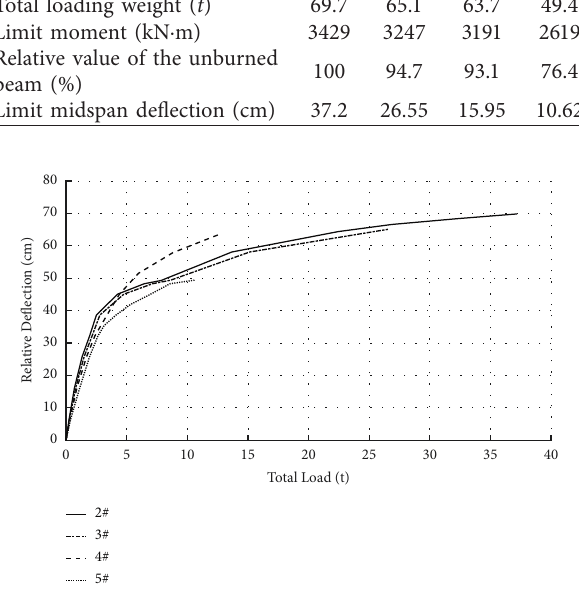
Figure 10: Deflection-load curves of beam 2# and beam 5# in Figure 11 is the contrast diagram of finite element simulation values between beam 2# and the unfired beam.